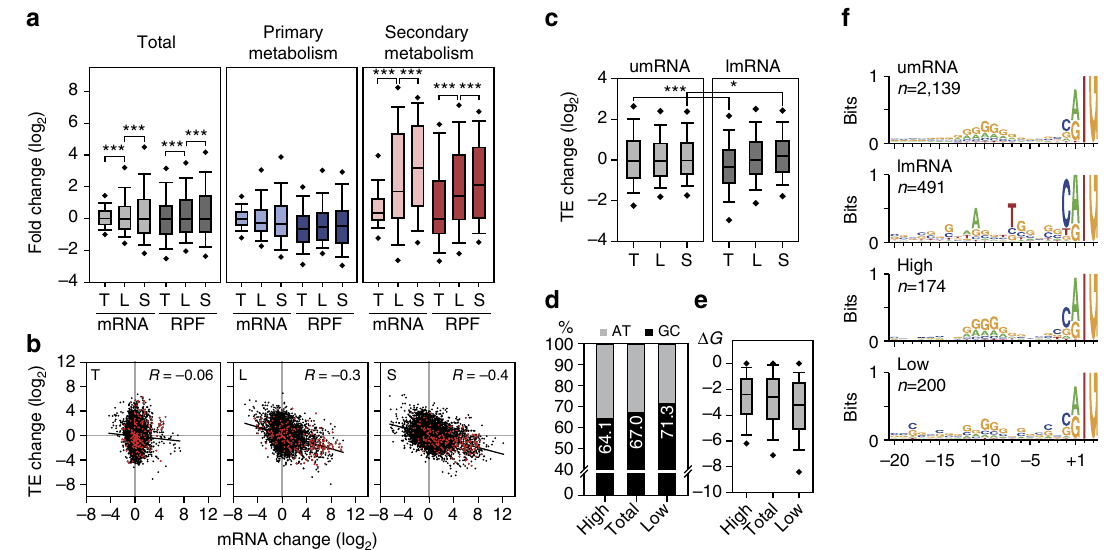
Figure 5 | Translational buffering revealed by comparison of changes in mRNA and ribosome-protected fragment abundances. ( a ) Distribution of mRNA fold-change and RPF fold-change of total genes, primary metabolic genes and secondary metabolic genes; *** P o 0.001 (Wilcoxon signed-rank test); T, fold-change between mid-exponential and transition phases; L, fold-change between mid- and late exponential phases; S, fold-change between mid- exponential and stationary phases. ( b ) Negative correlation between changes in mRNA levels and translational efficiency (TE) becomes higher at later growth phases. Red dots indicate secondary metabolic genes. ( c ) TE change distributions of umRNAs and lmRNAs across growth phases. * P o 0.05; *** P o 0.001 (Wilcoxon rank-sum test). ( d ) G þ C content of translation initiation regions (TIR: 20 nt sequence upstream of start codon); high, genes with high TE (upper 20%); total, all coding sequences; low, genes with low TE (lower 20%). ( e ) Correlation between free energy of TIR and TE. ( f ) Conserved ribosome-binding sequences for umRNAs were observed at 8–12bp upstream region of start codon; lmRNAs, 5 0 -UTR length ¼ 0. TIR of genes with high TE (High) shows more conserved polypurine (G 4 A) motif than genes with low TE